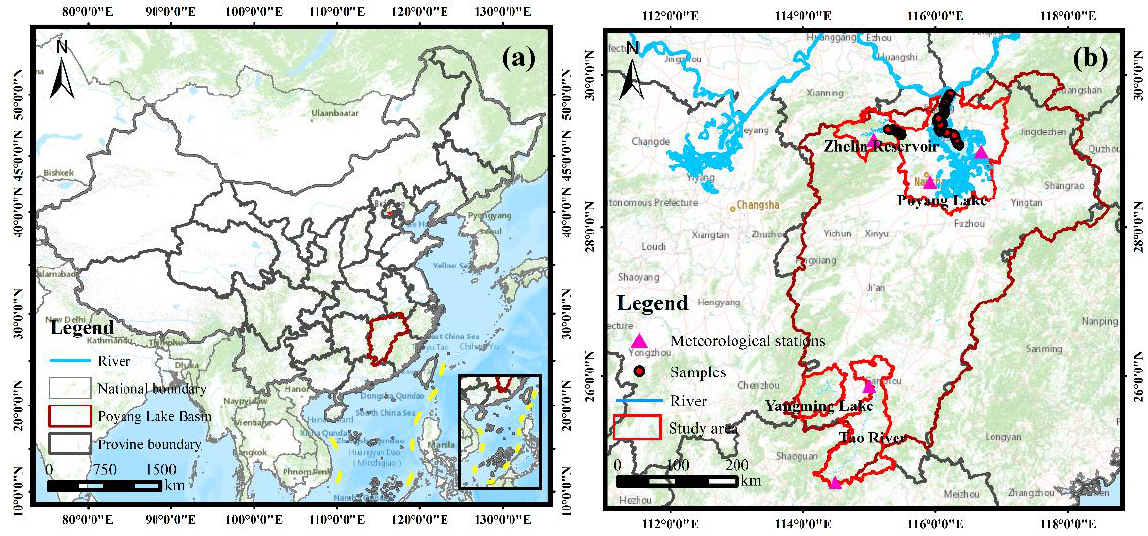
Figure 1. Study area. ( a ) Location of the study area. ( b ) The red points represent the locations of field measurement points at Poyang Lake and Zhelin Reservoir in 2016 and 2019 respectively. Pink triangles represent meteorological stations.